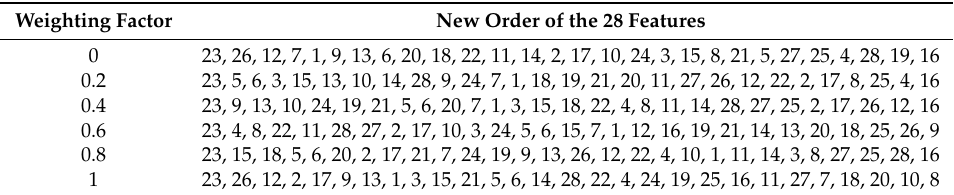
Table 2. The feature sequences under different weighting factors.